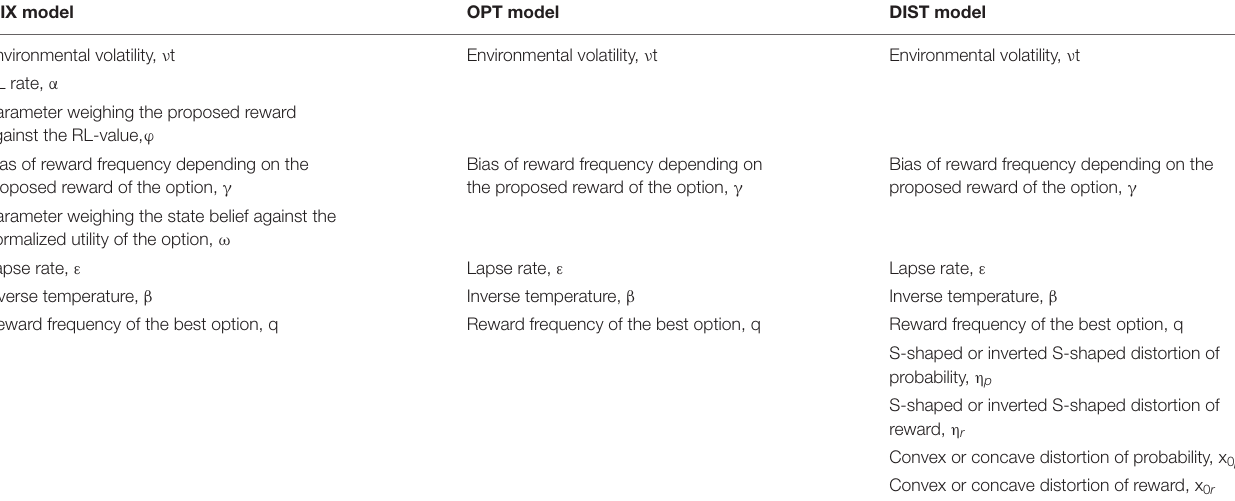
TABLE 1 | Free parameters of alternative